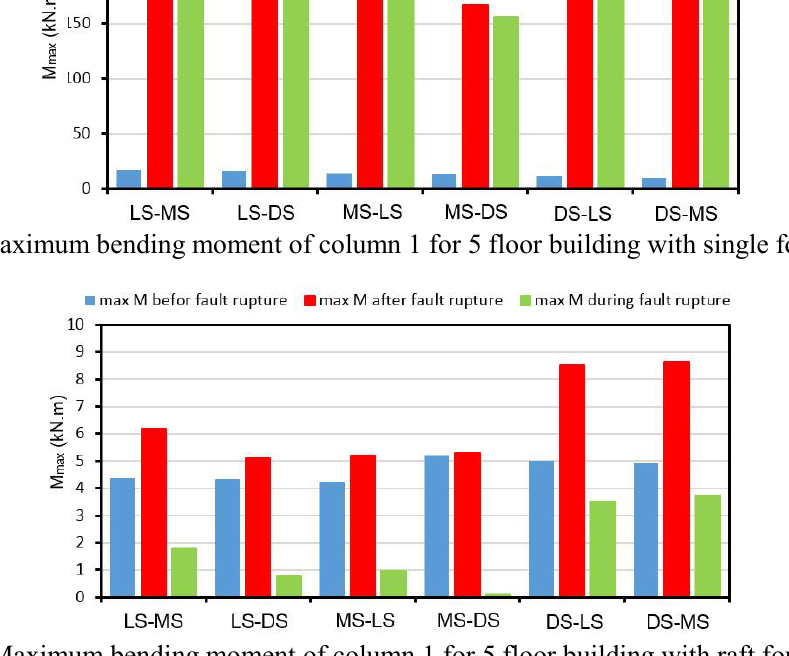
Fig. 25. Maximum bending moment of column 1 for 5 floor building with raft